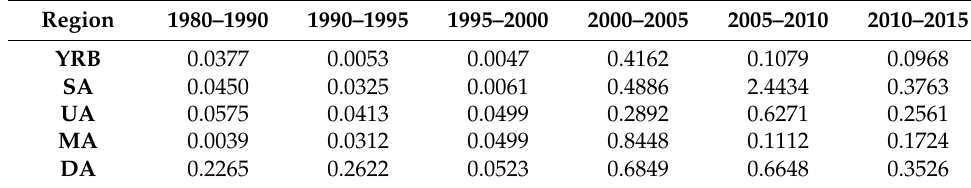
Table A6. Elasticity (E) from 1980 to 2015.